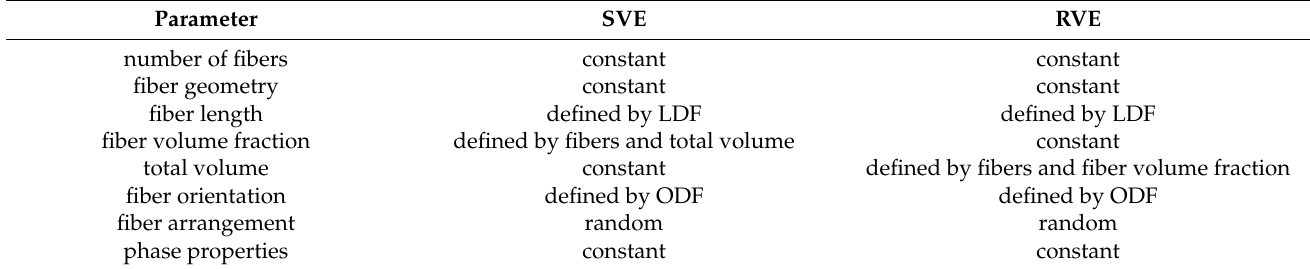
Figure 2. Two different approaches to define the finite volume: Statistical Volume Element (SVE) with constant dimensions and Representative Volume Element (RVE) with constant fiber volume fraction. Table 1. Comparison of the definition of parameters with the SVE and RVE approach.